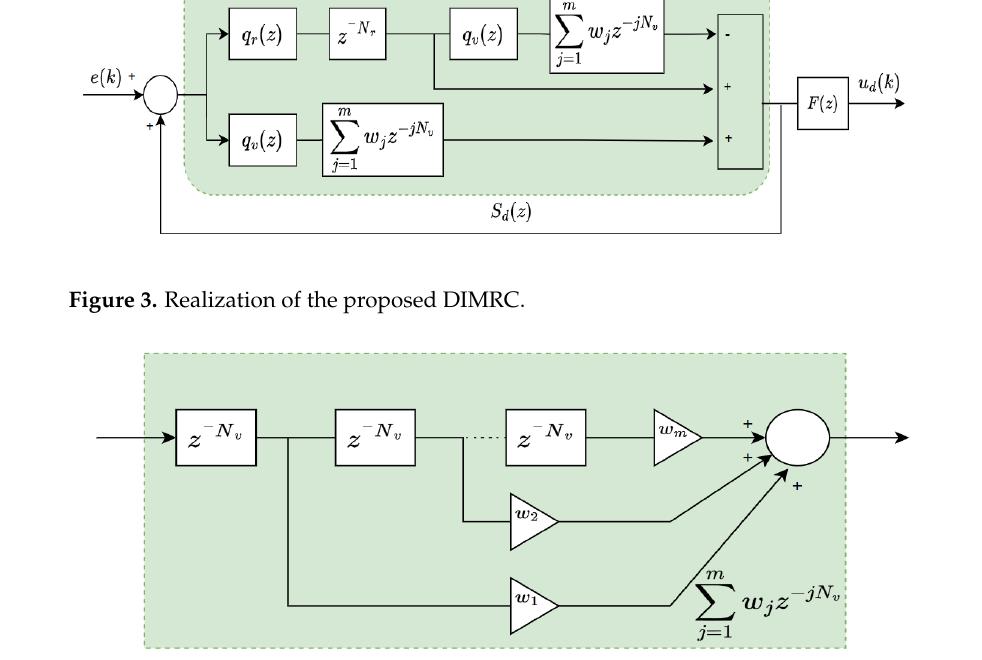
Figure 4. Realization of the weighted multiple delays.